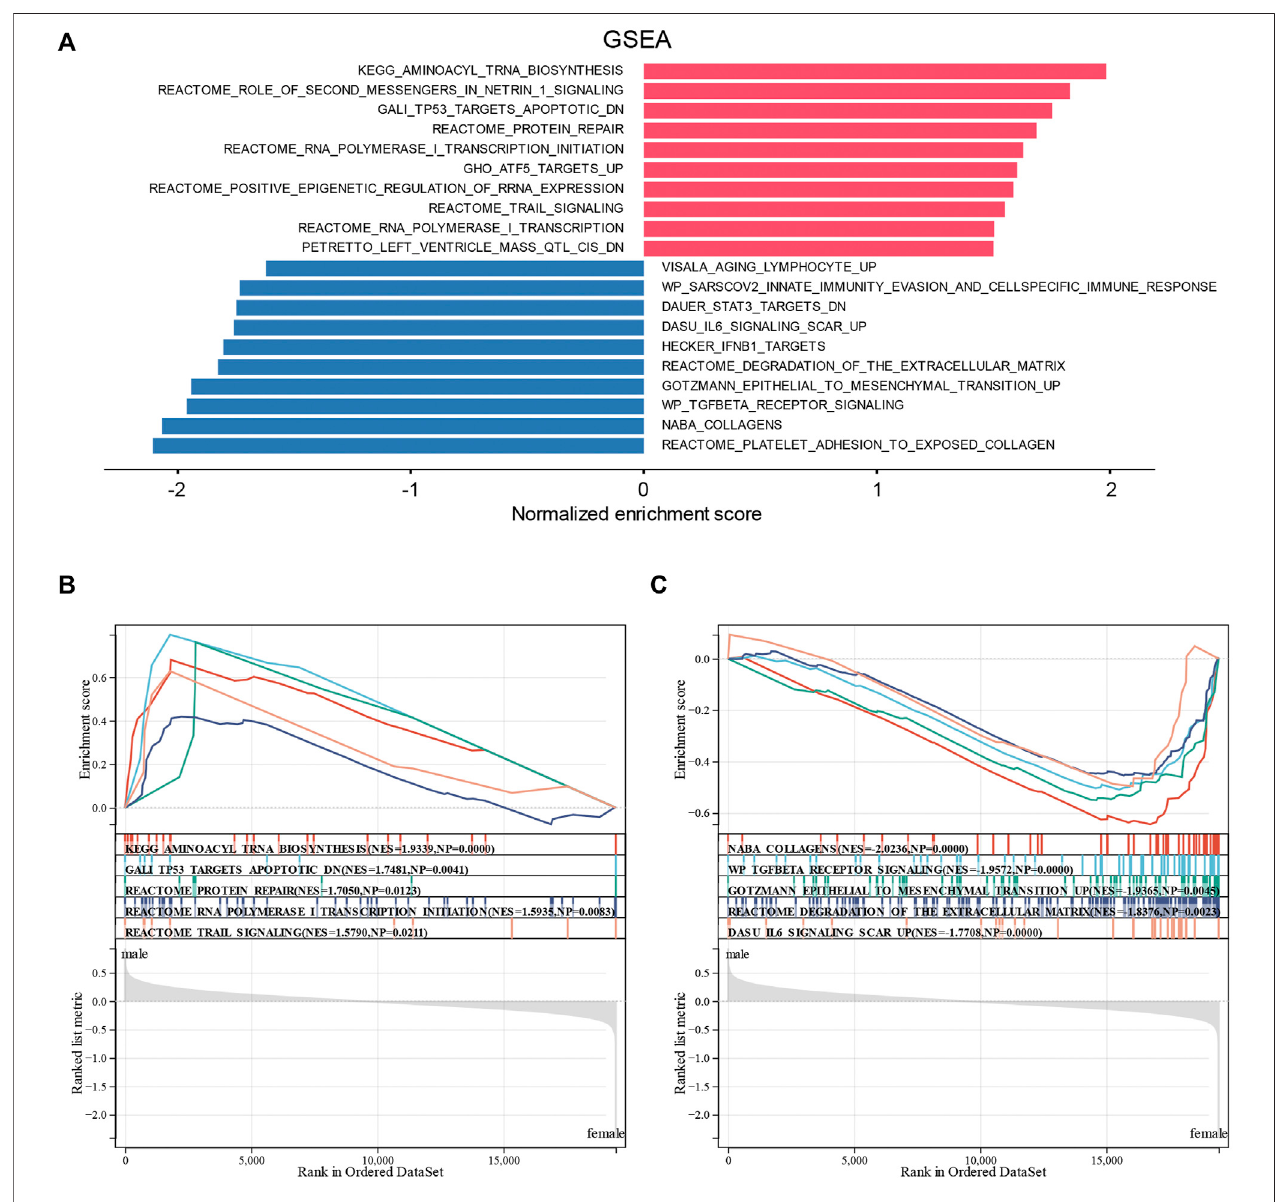
FIGURE 5 | Enrichment plots from GSEA. (A) Signi fi cantly enriched pathway annotations of DCM. (B) Signi fi cantly positive enriched pathways in male DCM patients. (C) Signi fi cantly positive enriched pathways in female DCM patients.